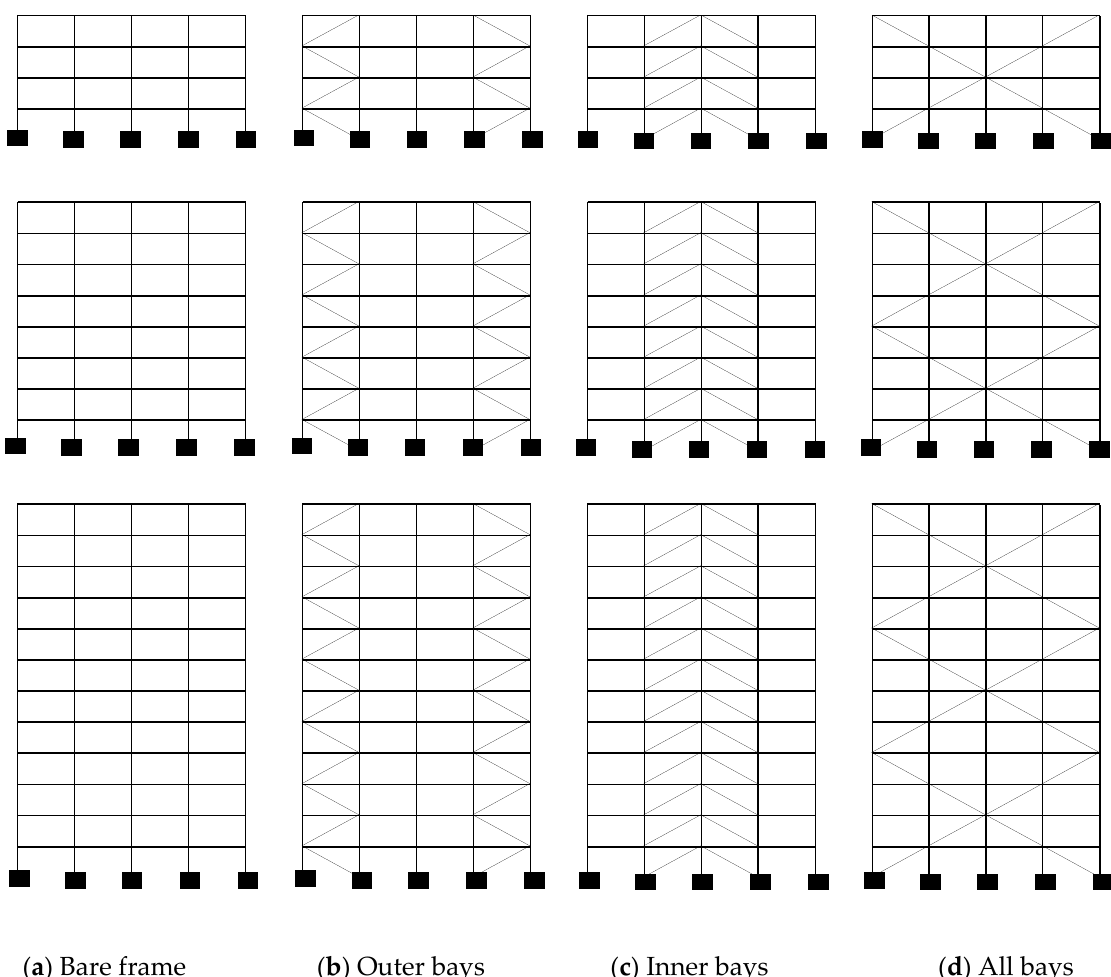
Figure 1. Elevation view of the frames with none bracing and with seismic protection devices.